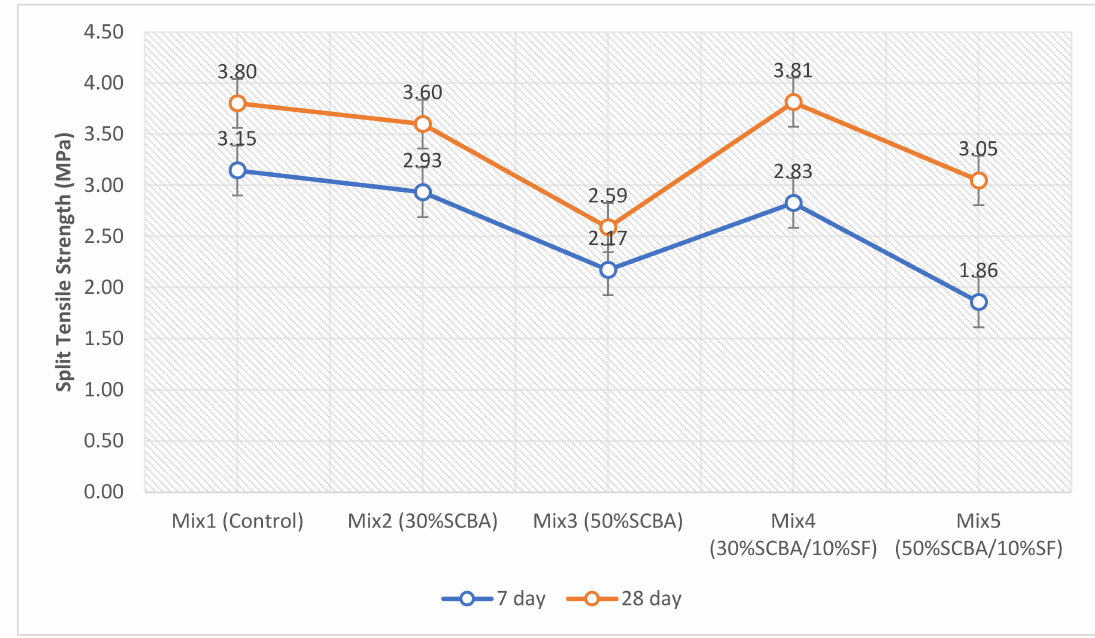
Figure 9. Split Tensile Strength test results at curing ages of 7 and 28